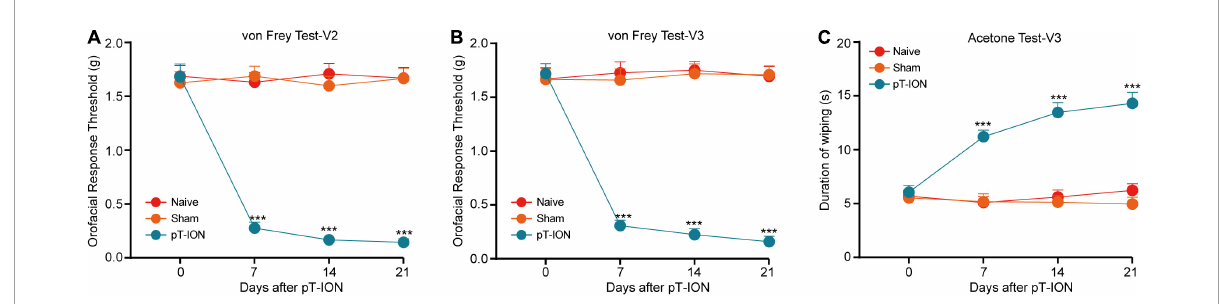
FIGURE1 The time course of chronic orofacial pain after pT-ION surgery. Persistent primary hyperalgesia in the V2 area (A) and secondary hyperalgesia in the V3 area (B) induced by pT-ION was shown as the reduced threshold to von Frey stimulus. Long-lasting secondary cold allodynia in the V3 area (C) induced by pT-ION was shown as an increased duration of wiping in response to acetone stimulus. N = 8 mice per group, *** p < 0.001 vs. Naive.